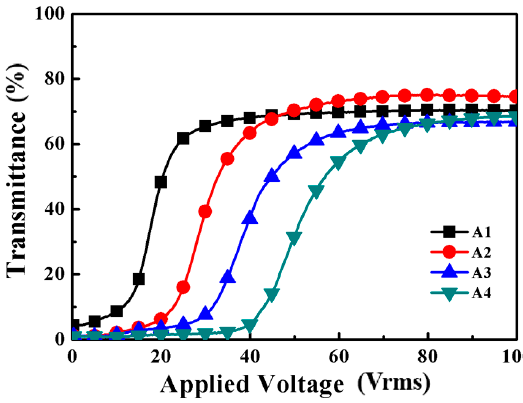
Figure 2. The transmittance-applied voltage curves of samples A1–A4.